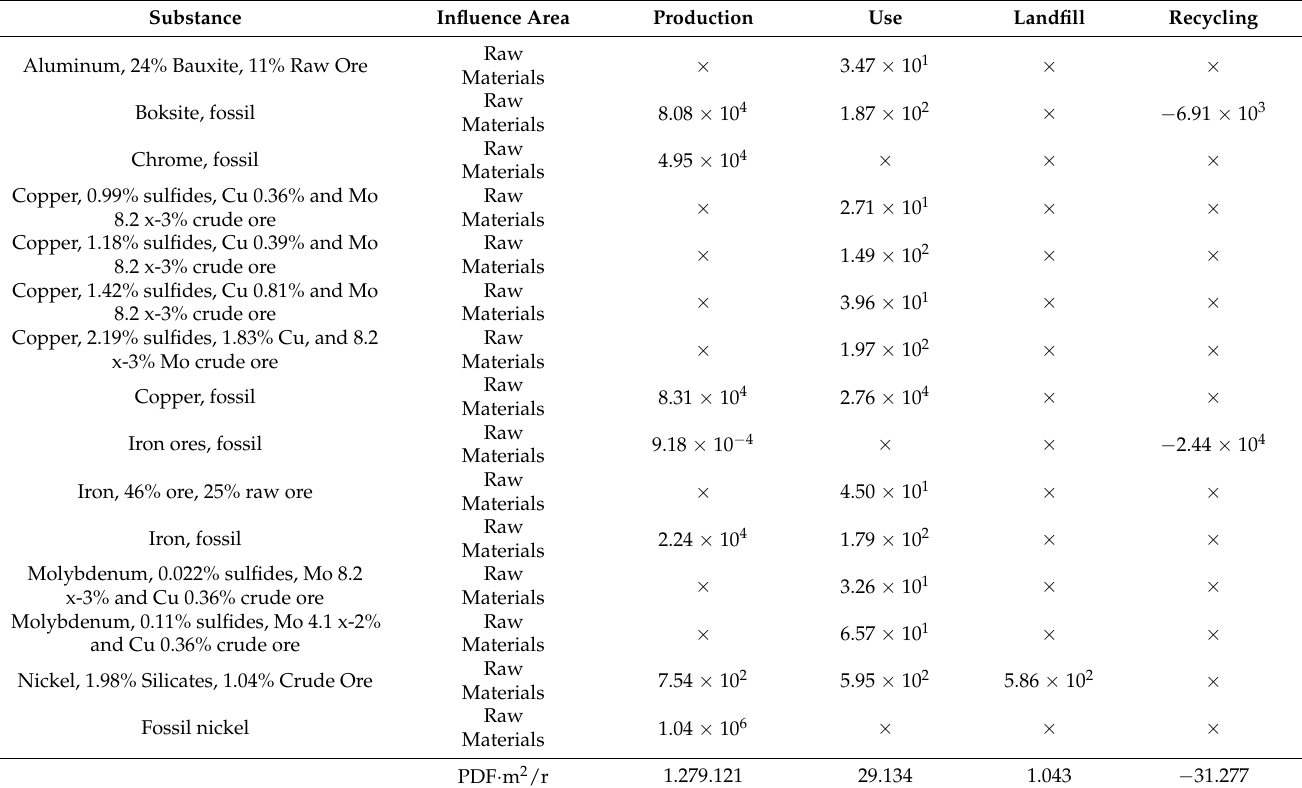
Table 9. The results of studies characterizing the environmental consequences for the processes related to the extraction of minerals occurring in the various stages of the life cycle of the Vestas V90, PDF m 2 /y [own research].